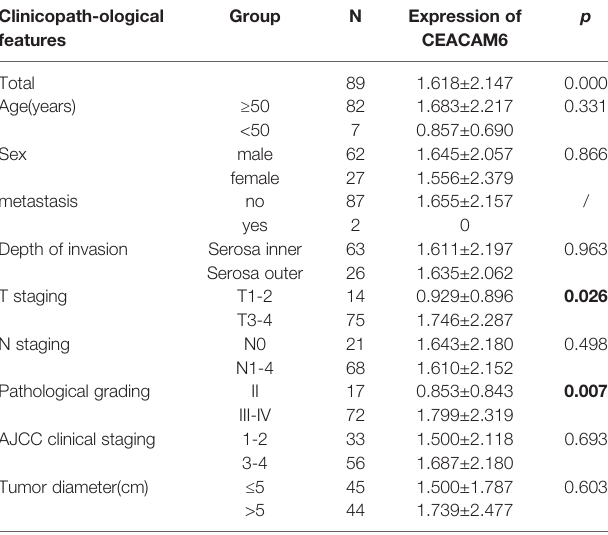
TABLE 2 | The relationship between expression of CEACAM6 and clinicopathological features of GC. Clinicopath-ological features